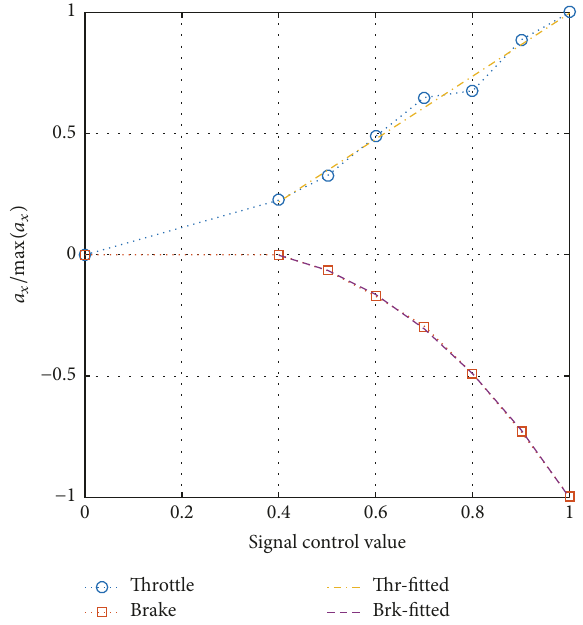
Figure 5: Longitudinal behavior of real test